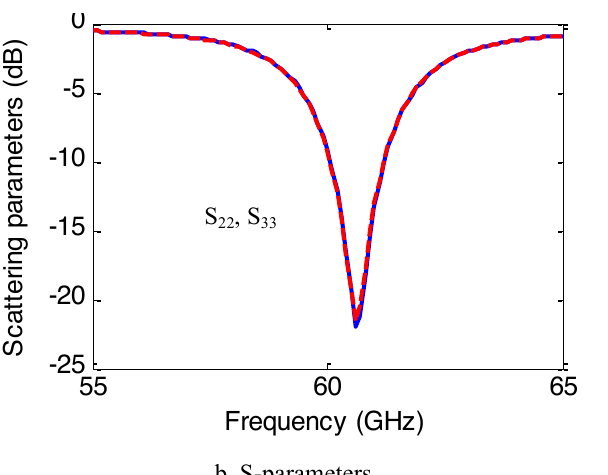
Fig. 10a. The detailed arrangement of the CP microstrip and the dual-polarized microstrip patch on-chip antenna with separation distance D. b. The variation of the reflection coefficient of the CP-microstrip patch on-chip antenna in the presence of the dual- polarized on-chip antenna versus frequency for different separation distance D. The variations of the reflection coefficient of the CP- microstrip patch on-chip antenna in the presence of the dual-polarized antenna versus frequency for different separation distance D are shown in Fig. 10b. The impedance matching bandwidth is varied between 2 GHz for D=0.5 mm and 2.4 GHz for D=2.5 mm with nearly the same resonant frequency. The variations of the transmission coefficient between the CP-microstrip patch on-chip antenna (port-1), X-port (3) and Y-port (2) versus frequency for different separation distance D are shown in Fig. 11. For the each separation distance D (D =D+3.8 mm) and D x x y (D =D+2.6 mm), the transmission coefficient has its y maximum value near the resonance frequency of the antennas for both X-and Y-port. As the distance increased the transmission coefficient decreased due to the broadside radiation of the X- and Y- port. For D=1.5 mm the transmission coefficient is -32 dB for the X-port and -35 dB for the